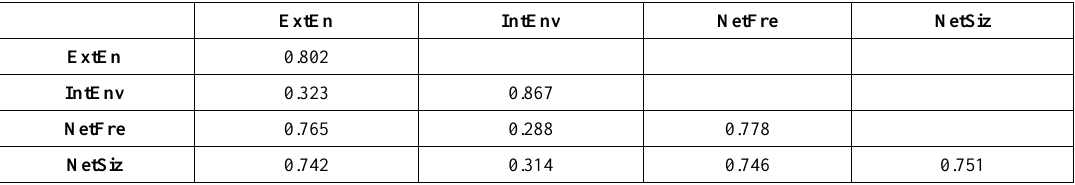
Table 3. Discriminant